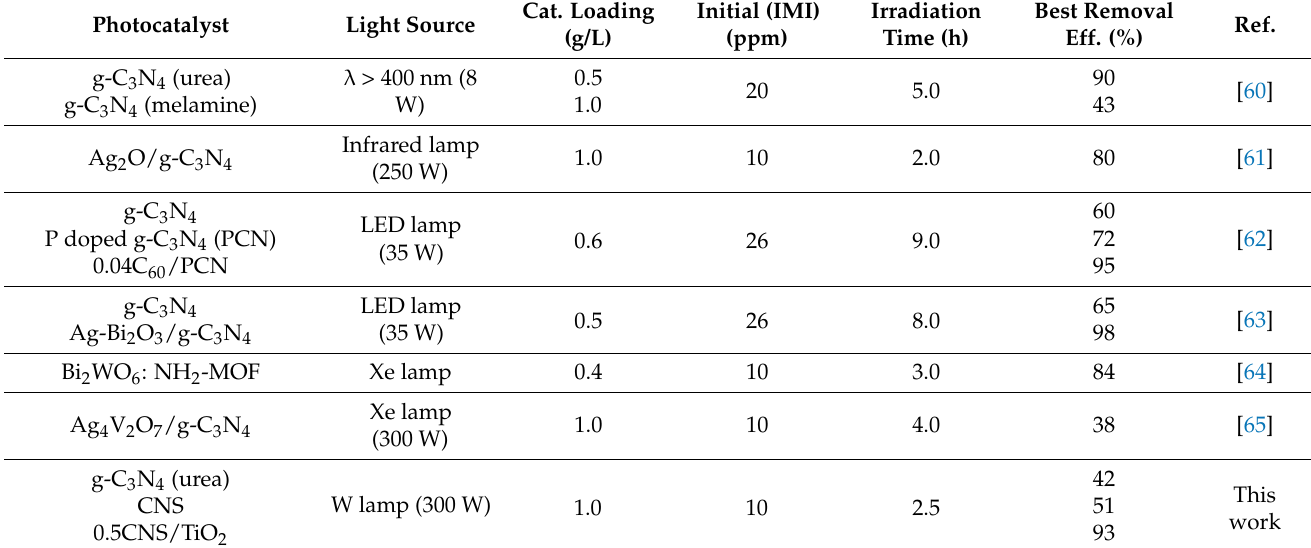
Table 1. Comparative photocatalytic degradation of imidacloprid pesticide at varying conditions, over various carbon nitride based materials.